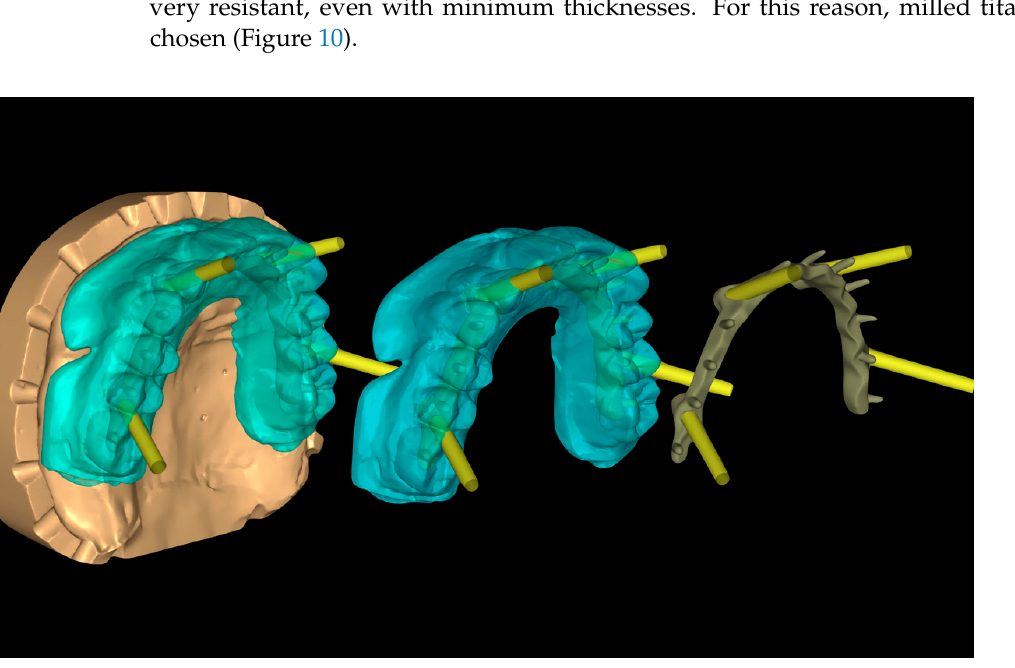
Figure 10. CAD project with Extragrade abutments for milled titanium reinforcement.